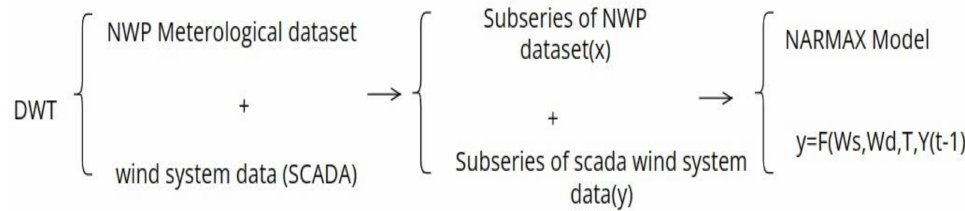
Figure 3. Explanation of dataset for NARMAX model for wind